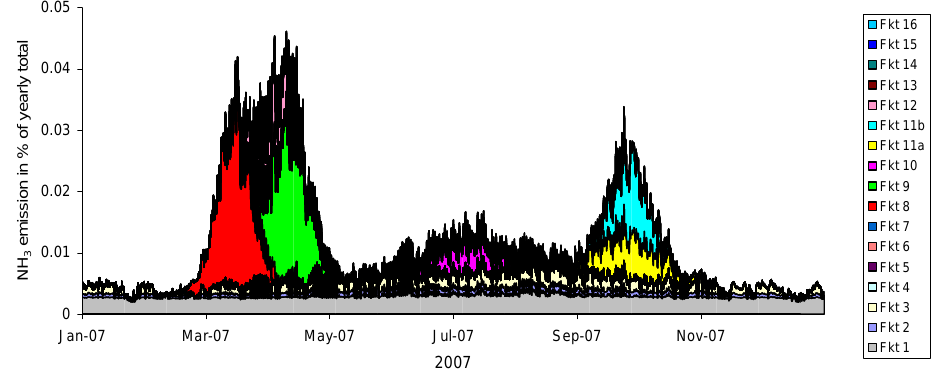
Fig. 3. Seasonal variations of the hourly NH 3 emissions separated into the various agricultural emission categories (described in Table 2) in the applied emission parameterisation. The emissions are shown as percentage of the yearly sum of all the 16 categories for the Tange site in the year 2007. Table 3. Statistical evaluation of the comparison between measurements (meas) and DAMOS or DEHM. The statistical parameters given are mean values, bias (= model mean – meas mean), variance and correlation coefficients ( r ) based on the Pearson method. See Table 1 for details about the sites (denuder and ALPHA data are included here). The bold numbers indicates best performance in the evaluation (that is lowest bias and highest correlation